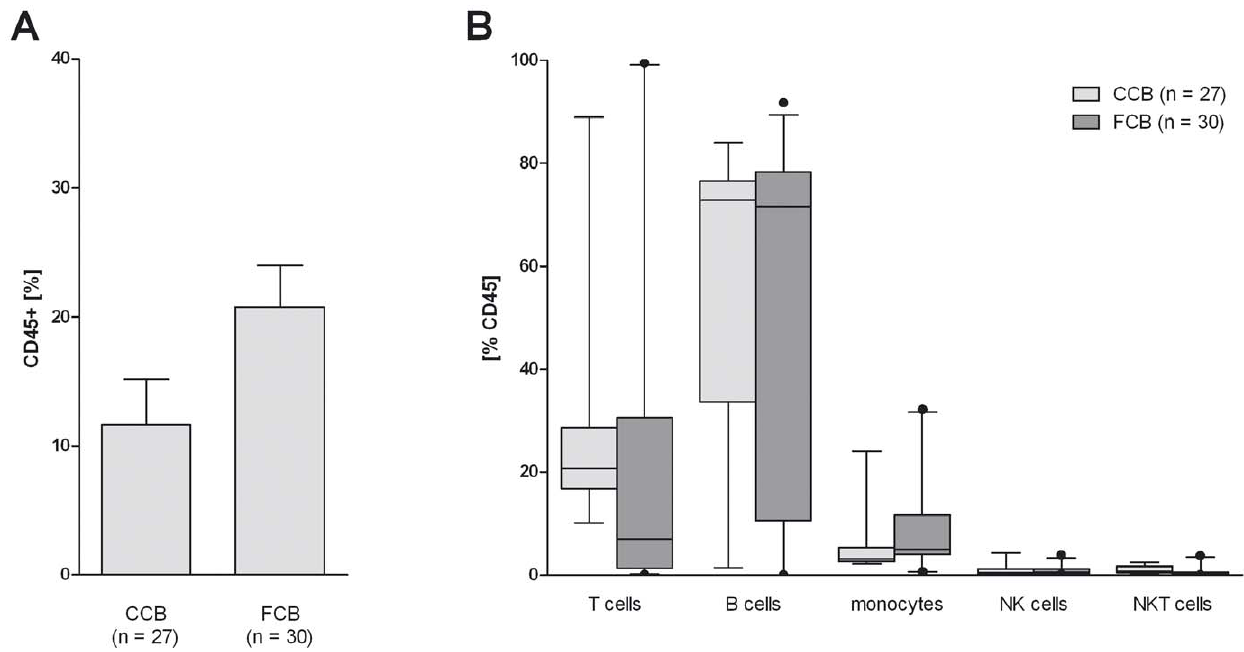
Figure 4. Comparison of reconstitution level in humanized mice transplanted with either blood bank CCB or FCB. The reconstitution of NOD-SCID IL2R c null mice with human immune cells were analyzed 6–8 weeks after transplantation of CD34 + cells by flow cytometry analysis of the peripheral blood. (A) The bar charts depict the percentage of huCD45 + cells in the live gate and (B) the percentage of different cell populations among huCD45 + cells. Bar plots depict the mean + SEM (A) or median and 5–95% percentile (B). doi:10.1371/journal.pone.0046772.g004 (Figure 1A). Nonetheless, after purification, the amount and the blood is unfavorable in blood bank CCB. This may result in an purity of CD34 + stem cells are lower in blood bank CCB increased number of destroyed cells and thus in an increased compared to FCB (Figure 1B, 2A, 2B). This might be due to the release of DNA during thawing. Even if DNAse buffer is used, the fact that the proportion of DMSO as freezing protection and cord remaining DNA agglutinates the living cells, which results in a